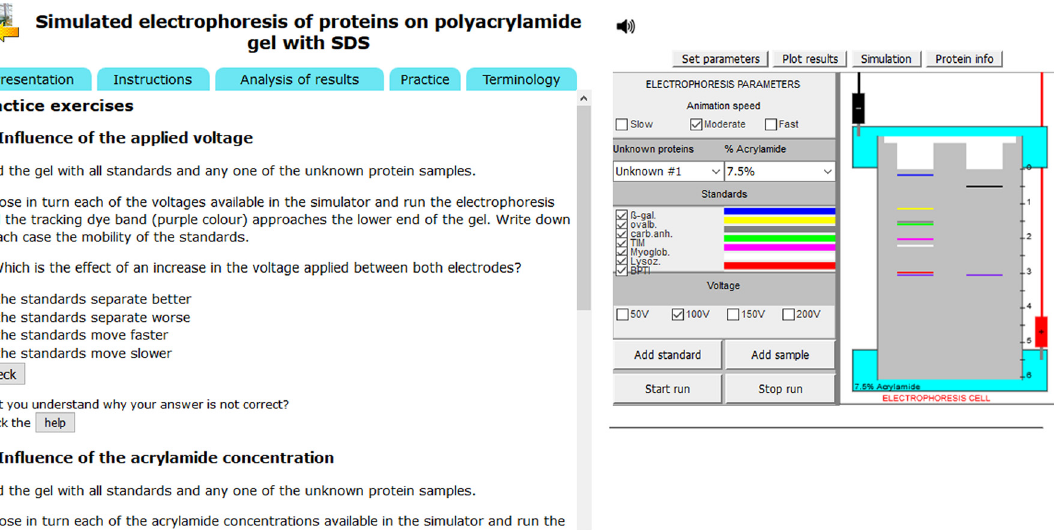
Figure 2: A simulation of protein electrophoresis on SDS-PAGE. Taken from ref. [5], Creative Commons BY-NC-SA Licence.